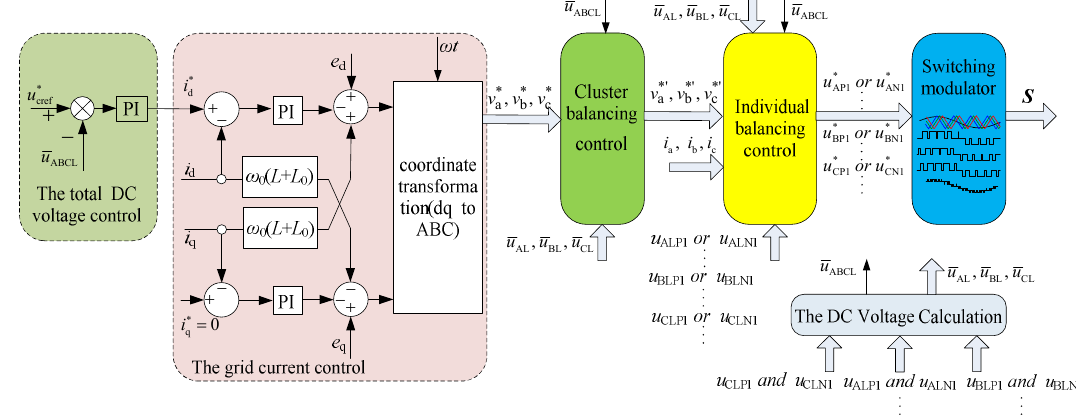
Figure 7. The control block diagram of the proposed DC short-circuit fault ride through strategy.